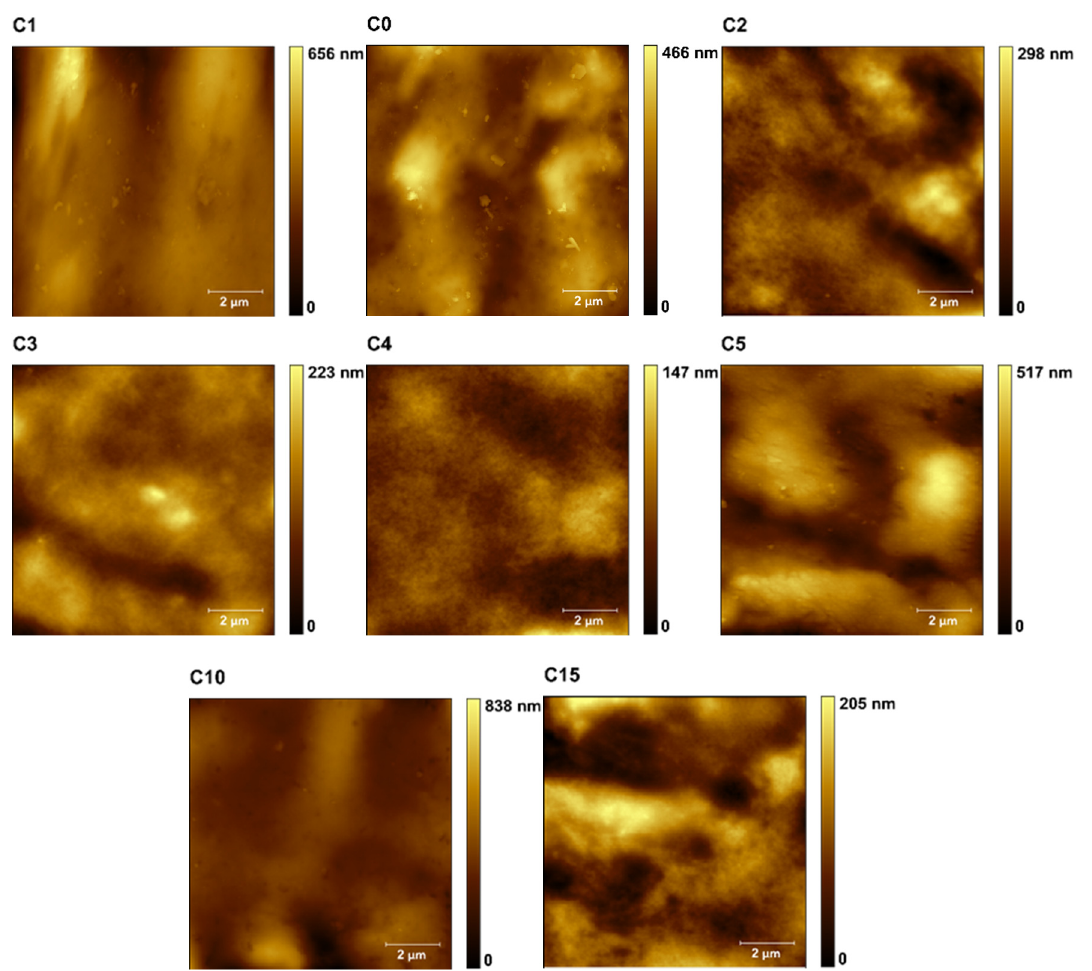
Figure 3. Representative maps of the topography (10 × 10 µm) of samples C0–C5, C10, and C15.